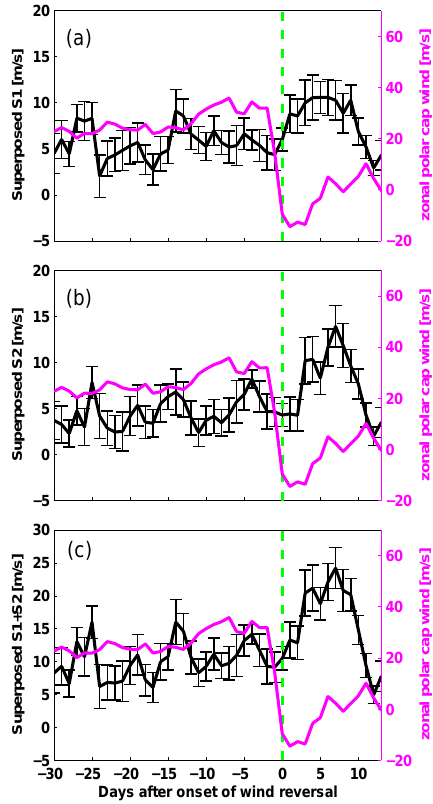
Figure 3. Composites of PW activity observed by SuperDARN around SSW events for the S 1 (a) , S 2 (b) and S 1 + S 2 (c) compo- nents (black) and the stratospheric ( ∼ 50km) polar cap zonal-mean zonal wind (magenta). The onset of the wind reversal is marked with a vertical green line at day